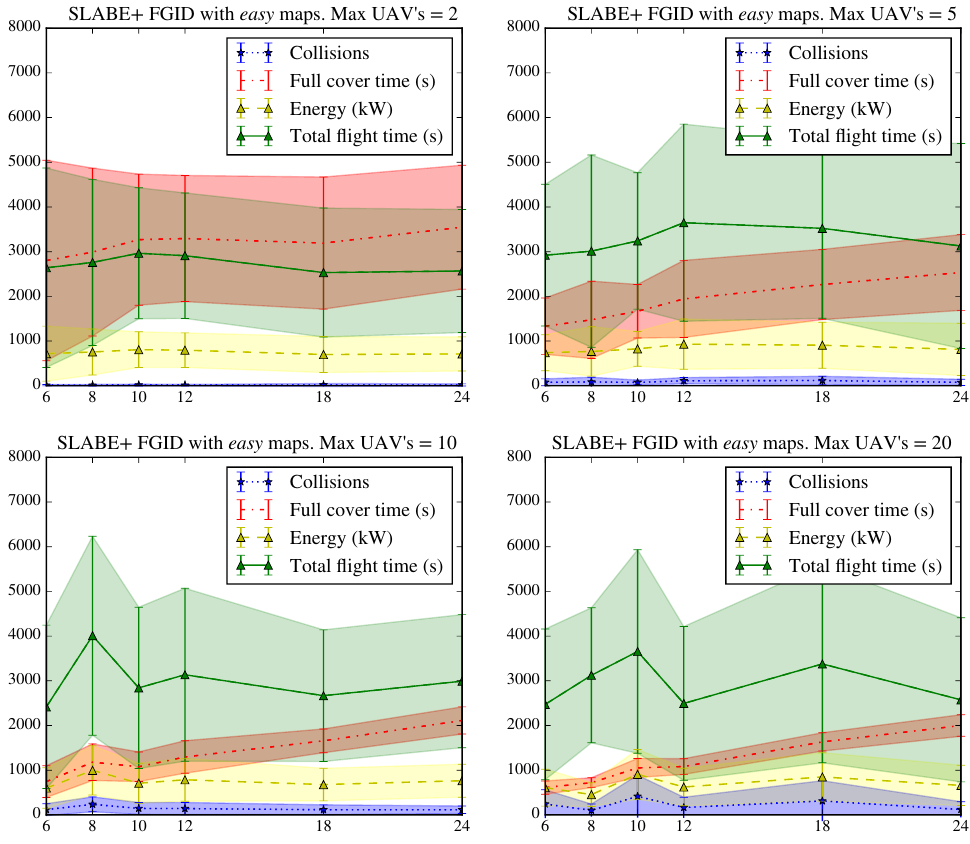
Figure 16. Results of the SLABE behavior simulations for the FGID take-off strategy in an easy environment. The graph shows the average evolution and variation of the number of collisions, the time required to achieve 95% coverage of the environment, the energy consumed by the swarm, and the total flight time for 600 simulations (50 simulations on the same map for each combination of take-off time interval and maximum number of vehicles in